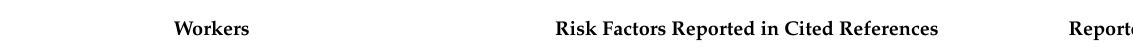
Table 2. Examples of Workplace COVID-19 Risks and Worker